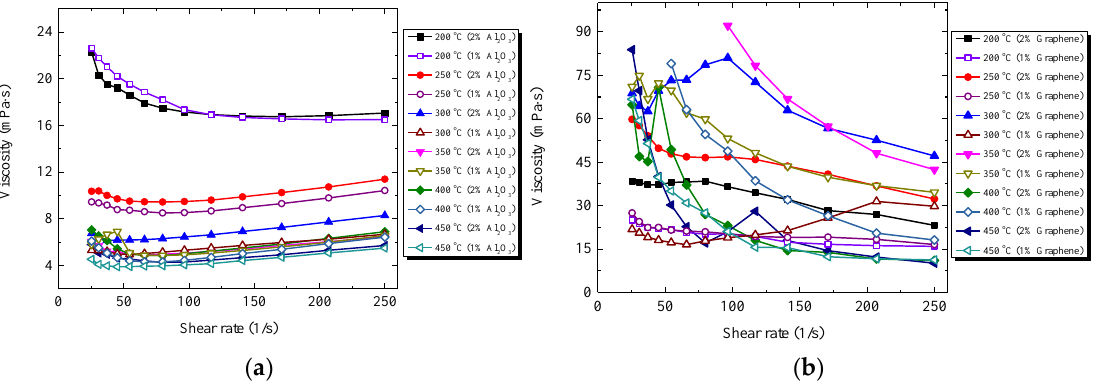
Figure 8. Viscosities of nanocomposites against different shear rates. ( a ) HITEC salt seeded with Al 2 O 3 nanopowder, ( b ) HITEC salt seeded with graphene. The addition of Al 2 O 3 nanopowder and graphene is with mass weight percentage.